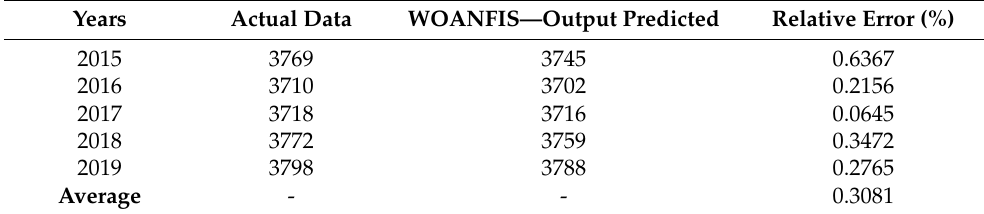
Figure 7. Comparing actual data and predicted values with WOANFIS. Table 3. WOANFIS operation.